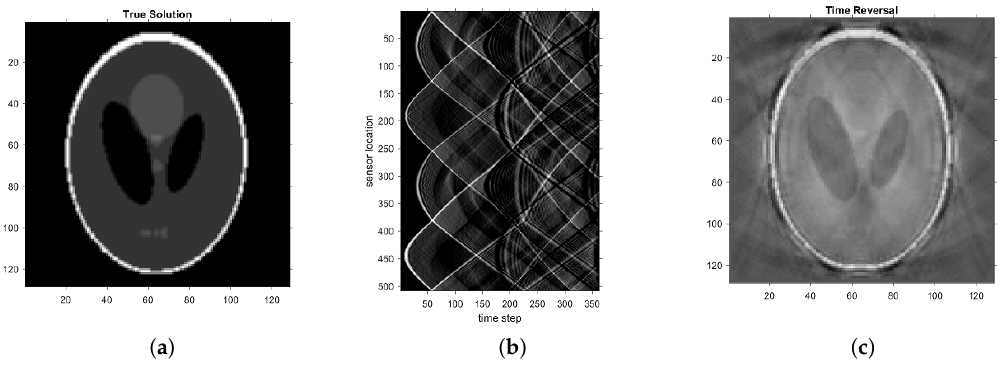
Figure 1. Numerical example to illustrate the effect of the acoustic reflections. ( a ): a 128 × 128 Shepp–Logan phantom as the initial pressure. ( b ): the recorded acoustic signal in the presence of sound hard reflectors. ( c ): reconstruction by conventional